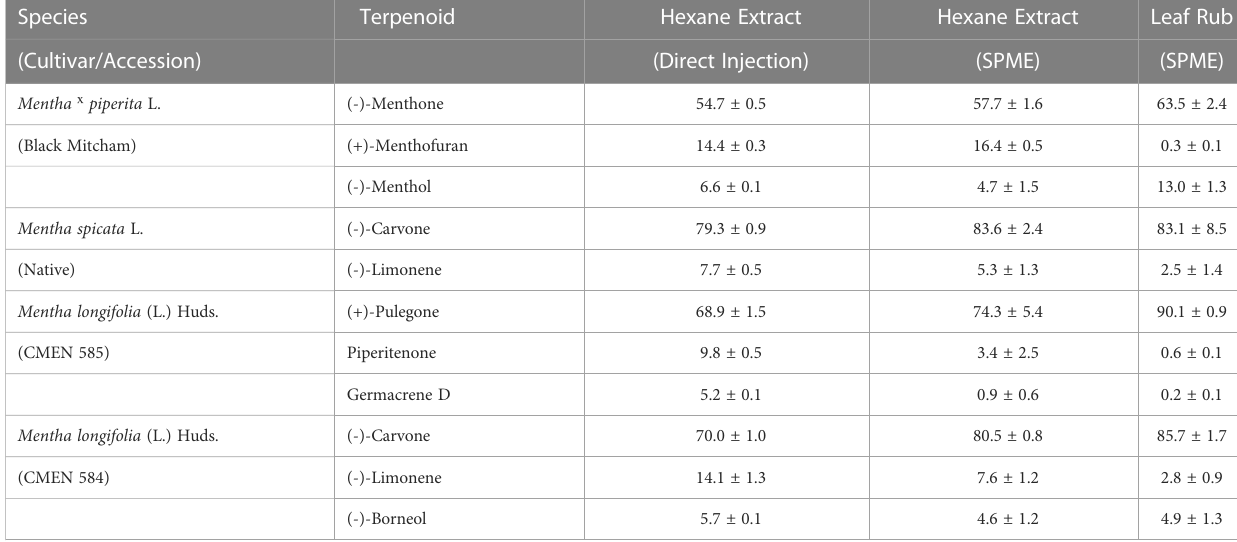
TABLE 1 Terpenoid pro fi les of mint leaves observed when employing different volatile capturing methods (expressed as percent of total volatiles with standard error; n = 3-5). Species